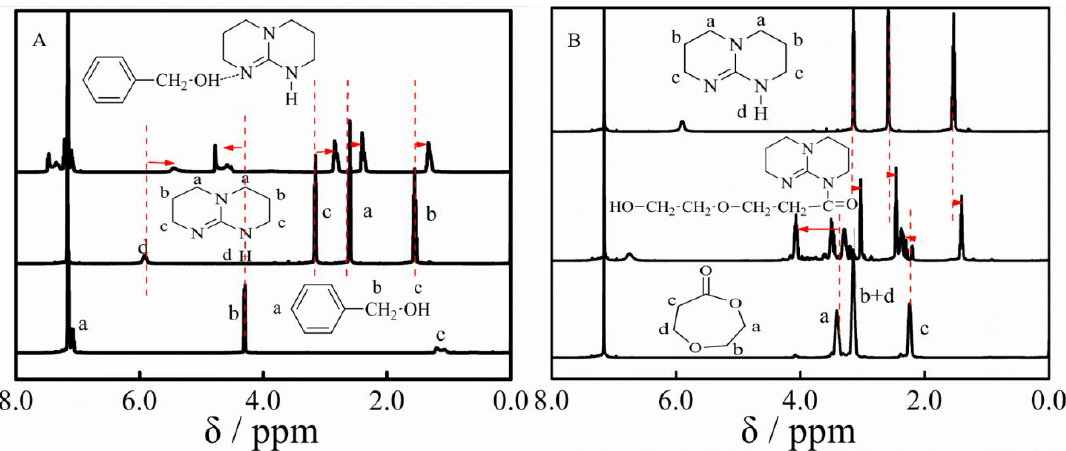
Figure 7. 1 H NMR spectra of ( A ) BnOH, TBD and their 1:1 complex in C 6 D 6 ; ( B ) DXO, TBD and their 1:1 complex in C 6 D 6.